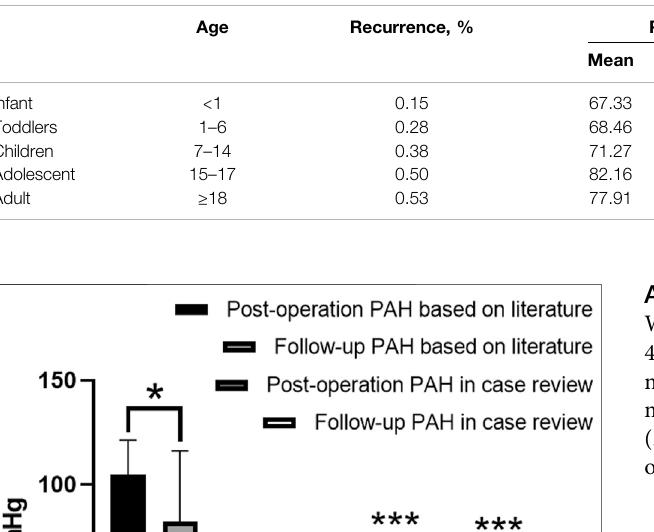
TABLE 5 | Comparison of recurrence and therapeutic effect in 5 age groups (Infant, toddlers, children, adolescent, and adult).